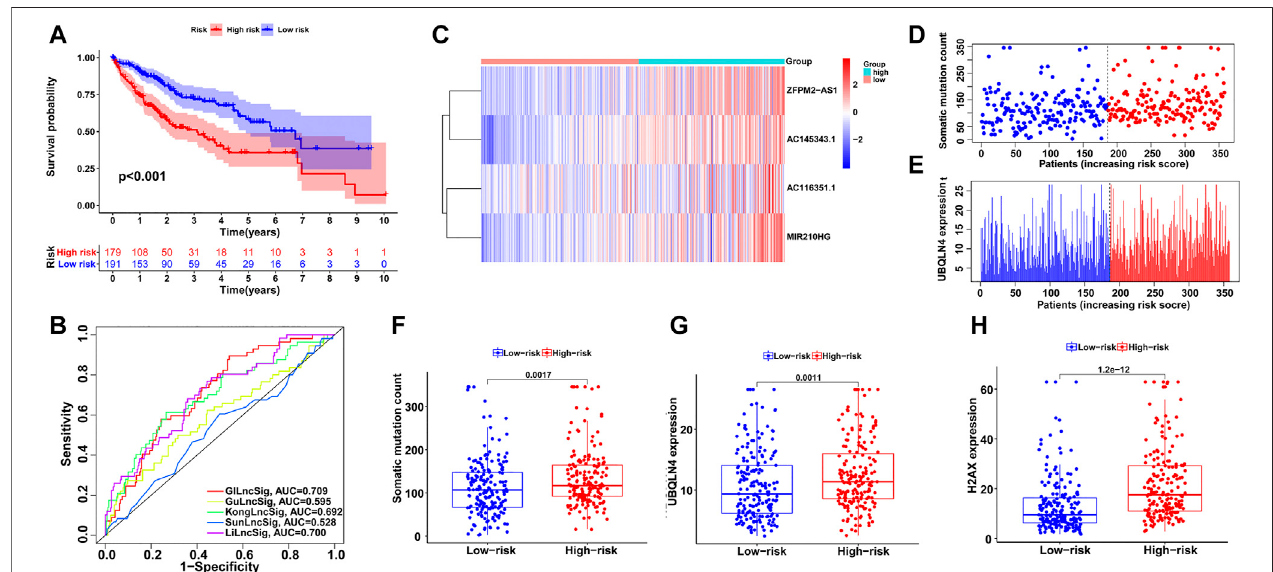
FIGURE 5 | Evaluation of the GILncSig in the TCGA set. (A) Kaplan – Meier survival analysis of high-risk and low-risk groups. (B) ROC analysis to evaluate the performanceofthe GILncSig,GuLncSig,KongLncSig,SunLncSigand LiLncSig. (C) Theexpression pattern ofthe GILncSigin theTCGA set. (D) Distributionofsomatic mutations with increasing risk score. (E) UBQLN4 expression with increasing risk score. The boxplots of the distribution of somatic mutations (F) , UBQLN4 expression (G) and H2AX expression (H) between the high-risk and low-risk groups in the testing group.